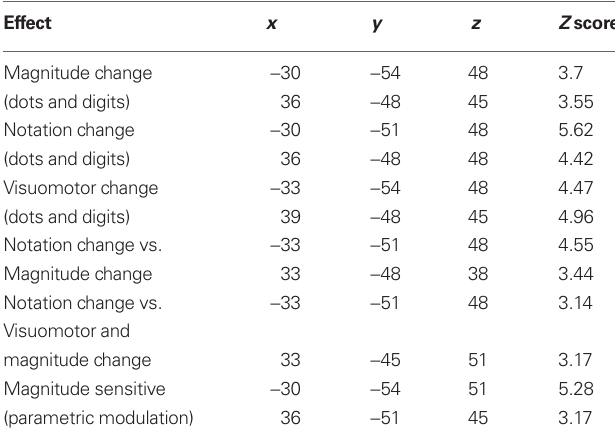
Table 2 | effects of change within the